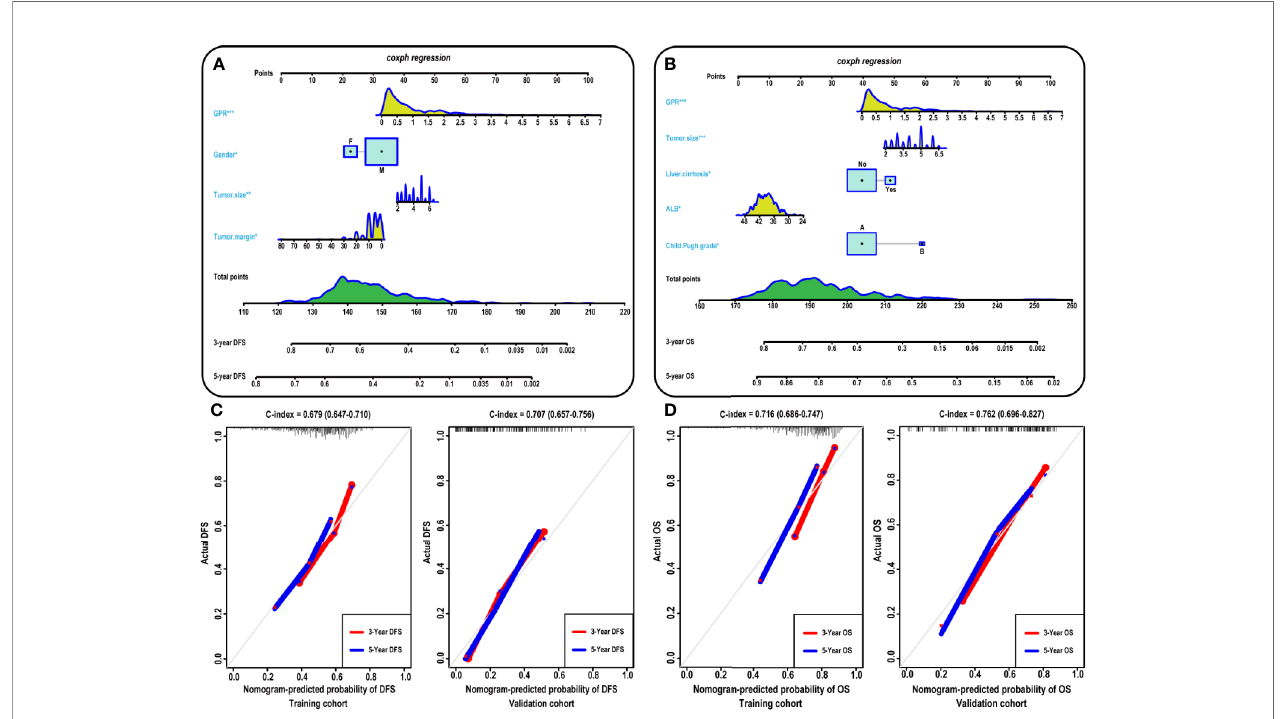
FIGURE 3 | Construction and calibration of the nomogram models. (A – B) Development of the nomogram to predict the 3- and 5-year DFS (A) and OS (B) rates for HCC. Calibration curves showing the predictive accuracy for the 3- and 5-year DFS rates of the HCC patients in the training (C-left) and validation (C-right) cohort. Calibration curves showing the predictive accuracy for the 3- and 5-year OS rates of the HCC patients in the training (D-left) and validation (D-left) cohort. ALB, albumin; GPR, gamma ‐ glutamyl transpeptidase ‐ to ‐ platelet ratio; DFS, disease-free survival; OS, overall survival; HCC, hepatocellular carcinoma.